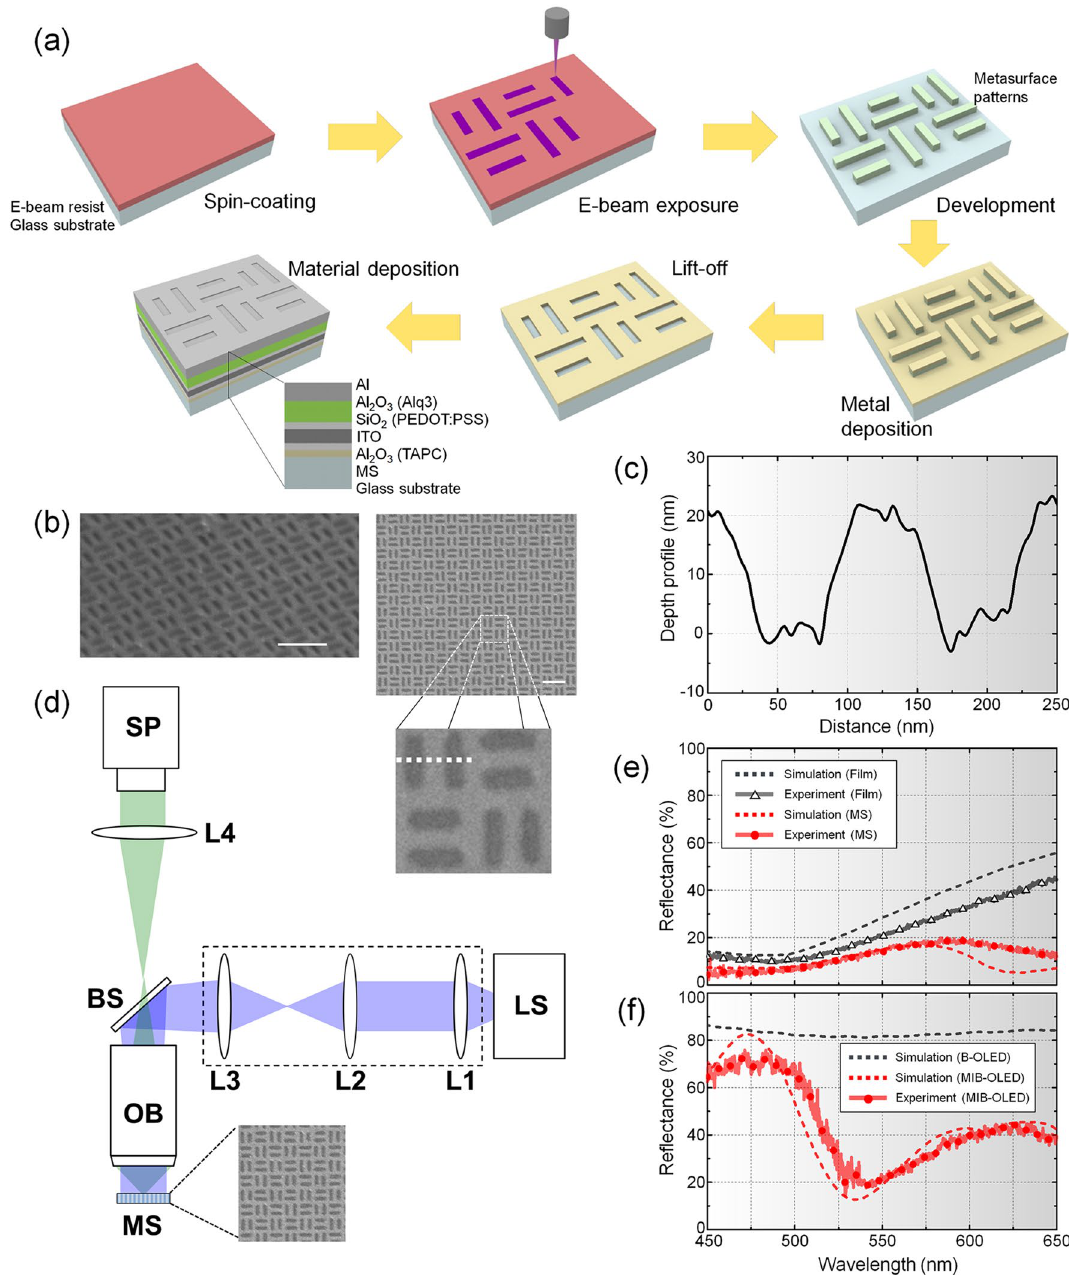
Figure 4. ( a ) Schematic diagram of the fabrication processes to implement the MIB-OLED model along with a final cross-section. ( b ) SEM image of a fabricated MS sample prior to material deposition (scale bars: 500 nm): tilted (left) and top view (middle). The magnified image on the right represents a unit MS pattern with a 500-nm size. ( c ) Depth profile of the measured SEM image of slots across the white dashed line in ( b ). ( d ) Schematic set-up for passive experimental characterization of MS for the MIB-OLED model (LS: light source, OB: objective lens, BS: beam splitter, SP: spectrometer, and L1–L4: collimation optics). ( e ) Measured and simulated reflectance spectra for only MS and gold thin film deposited on BK7 substrate. Thickness of MS and gold film is 20 nm and MS composed of mixed-slot arrays whose structural parameters of L 1 , L 2 , and W are fixed to 200, 160, and 60 nm, respectively. ( f ) Comparison of reflectance spectrum between conventional B-OLED and MS-integrated cavity structure. Integrated MS has a 20-nm thickness and its structural parameters of L 1 , L 2 , and W are 200, 160, and 60